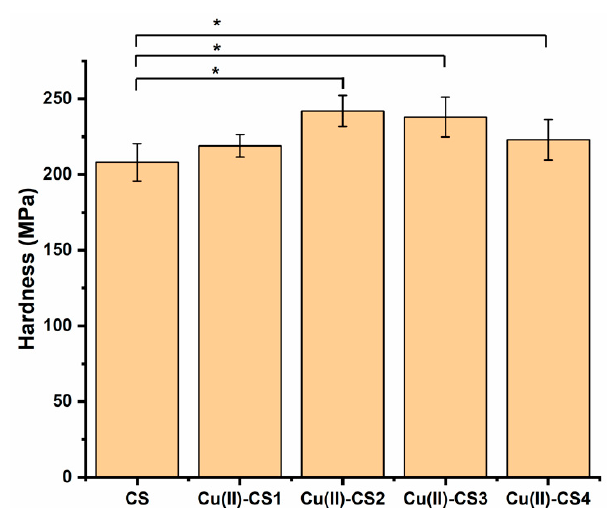
Figure 5. Overall variation of the hardness of the di ff erent coatings. Significantly di ff erent coatings from the CS coating are highlighted (* p < 0.05).